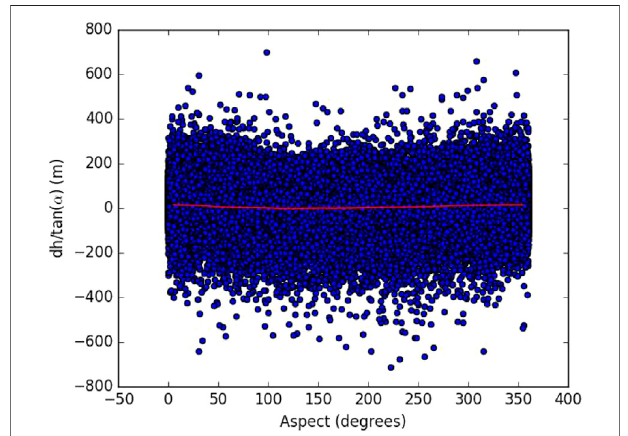
FIGURE 2 | Scatterplot of slope standardized elevation differences between TOPODEM and SRTM DEM after co-registration.